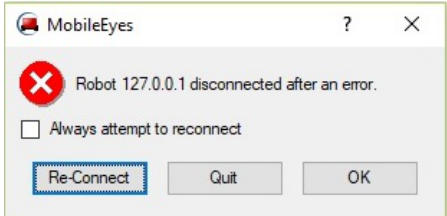
Figure 3. MobileEyes reconnect message if it loses connection during a session.